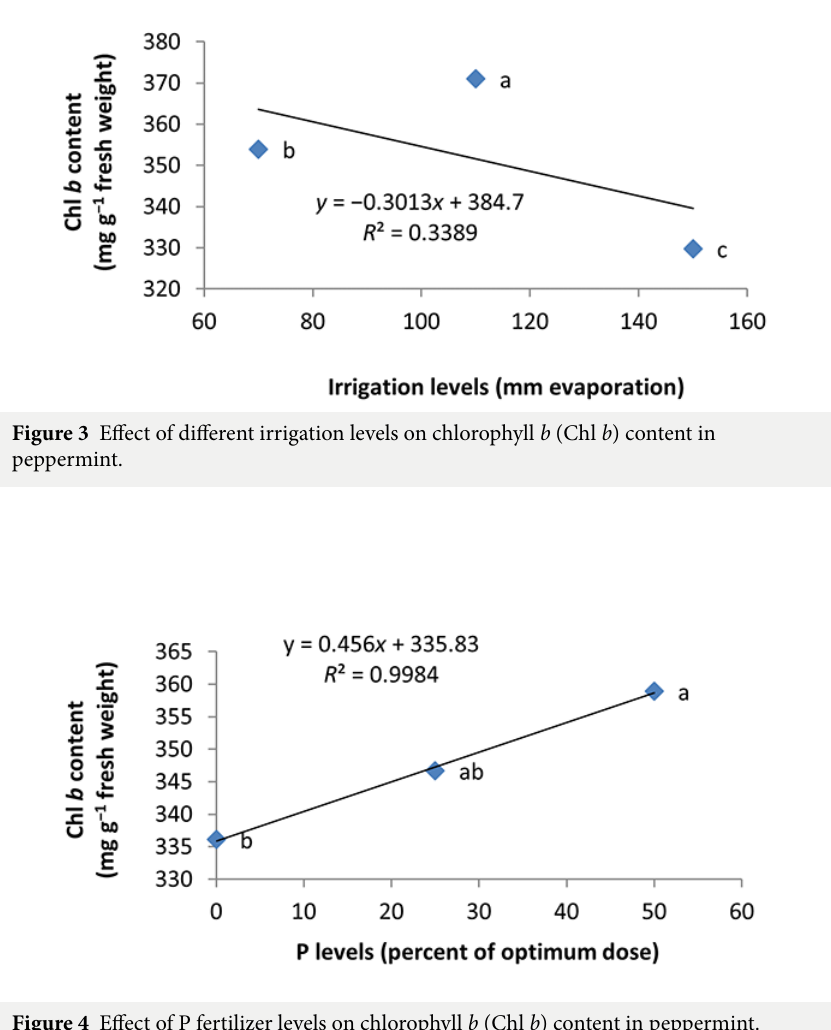
Figure 4 Effect of P fertilizer levels on chlorophyll b (Chl b ) content in